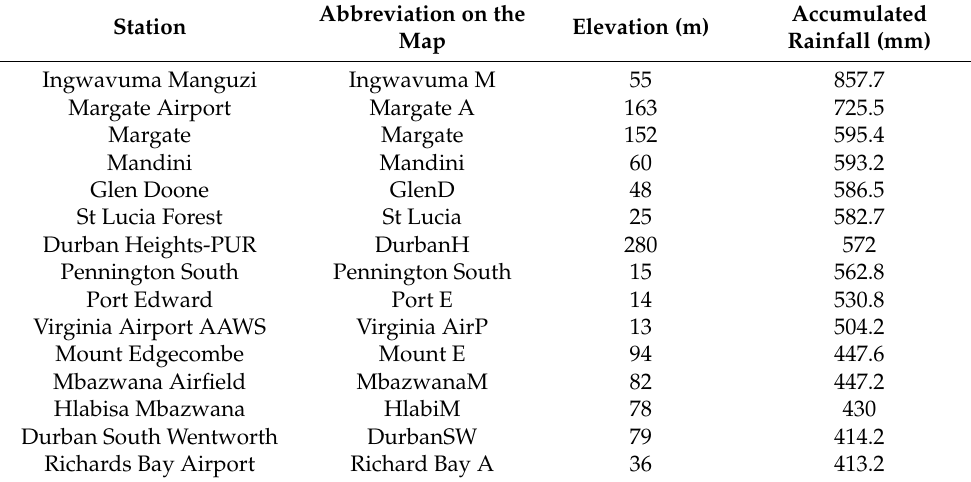
Table 2. Notable daily rainfall totals accumulated during 6–21 April 2022 from the SAWS. Abbreviation on the Station